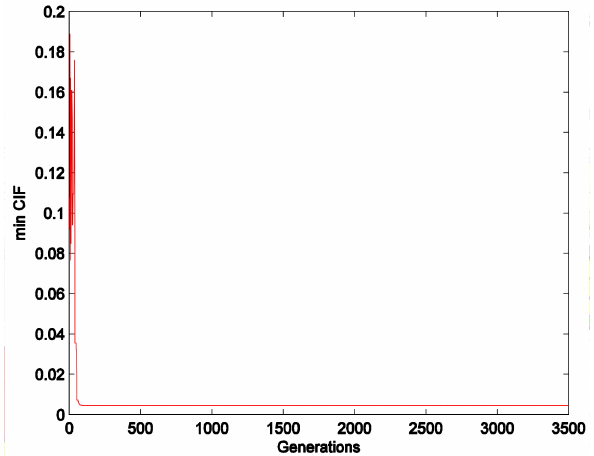
Figure 2. Convergence graph for the min consistent inspection function (CIF)